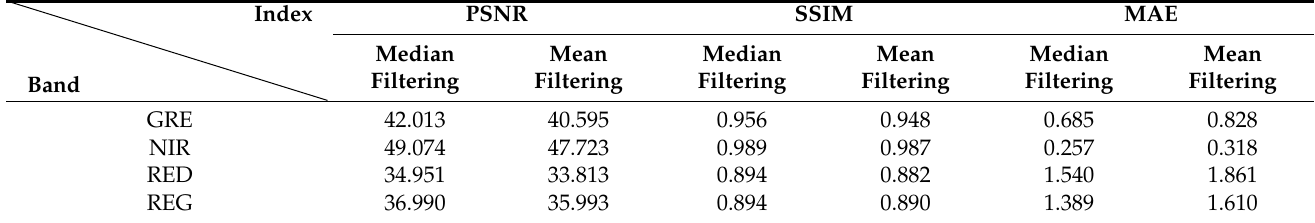
Table 2. Evaluation indexes of the multispectral image